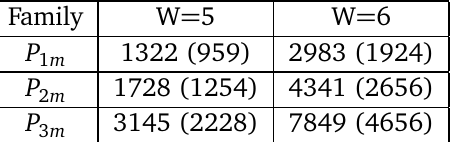
Table 2: Number of GPLs entering in the solution. Top-sector b.e. in parenthesis.